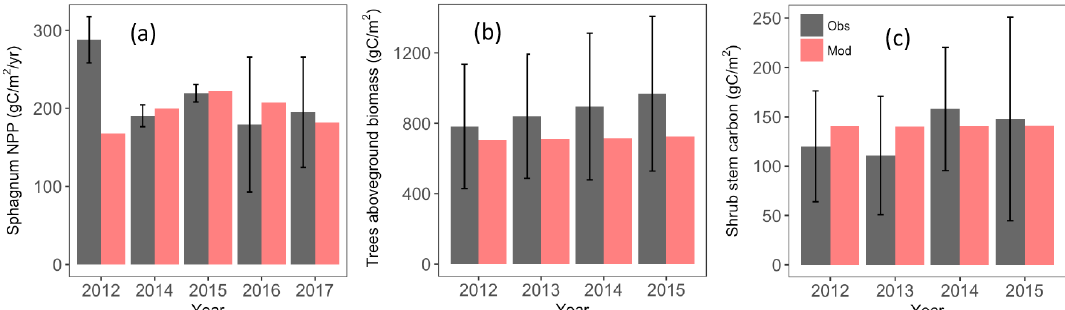
Figure 4. Predicted (red bars) Sphagnum NPP (a) , aboveground tree biomass (b) , and shrub stem carbon (c) compared with the observations (black bars). Observed NPP data are based on growth of 12–17 bundles of 10 Sphagnum stems in 2012–2015 (unpublished data) and in two ambient plots by the method described by Norby et al. (2019) in 2016–2017 (data in Norby and Childs, 2018). The Sphagnum NPP data for the years 2015–2017 and aboveground tree biomass and shrub stem carbon for the years 2014–2015 are independent of the related parameter